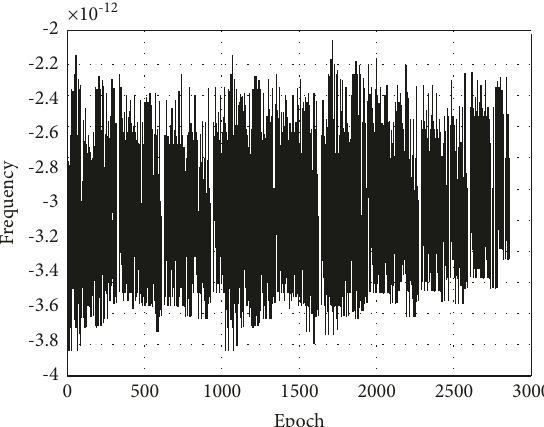
Figure 3: Frequency data of PRN10 satellite after removing gross errors.